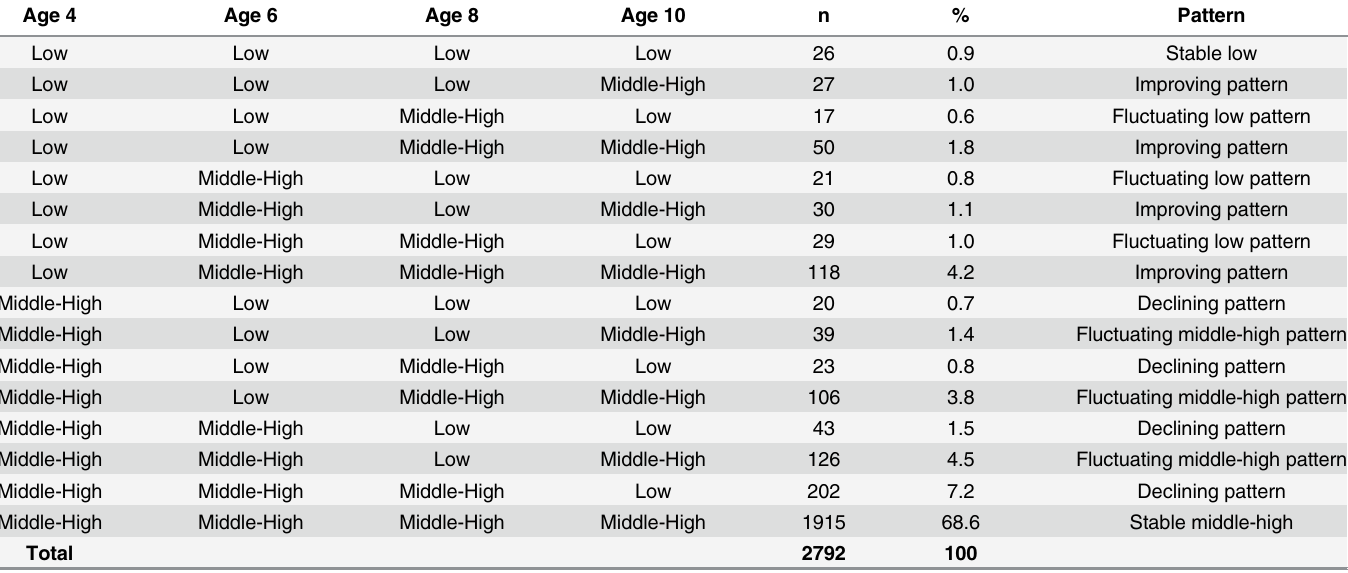
Fig 2. Positional movement in language and literacy at ages 4, 6, 8 and 10. doi:10.1371/journal.pone.0135612.g002 What Fig 2 does not show is specific grouping of children in patterns of stability and change. If we consider that a child can be grouped as either ‘ low ’ or ‘ middle-high ’ at ages 4, 6, 8 and 10, there are 16 (2 4 ) possible combinations of language development across time. Table 3 illustrates these combinations. These groupings of language development can be split into six broad patterns: 2 patterns of stability and 4 patterns of change. Broadly, children can either be stable in their language (i.e. the same position at each age) or they can change (i.e. they change position at least once between ages). The two stable patterns were a stable middle-high pattern (i.e., middle-high across all 4 ages) and a stable low pattern (i.e., low across all 4 ages). The most common devel- opmental pattern was the stable middle-high pattern, 69% of the children were middle-high at Table 3. Language performance within the 4-year, 6-year 8-year, and 10-year